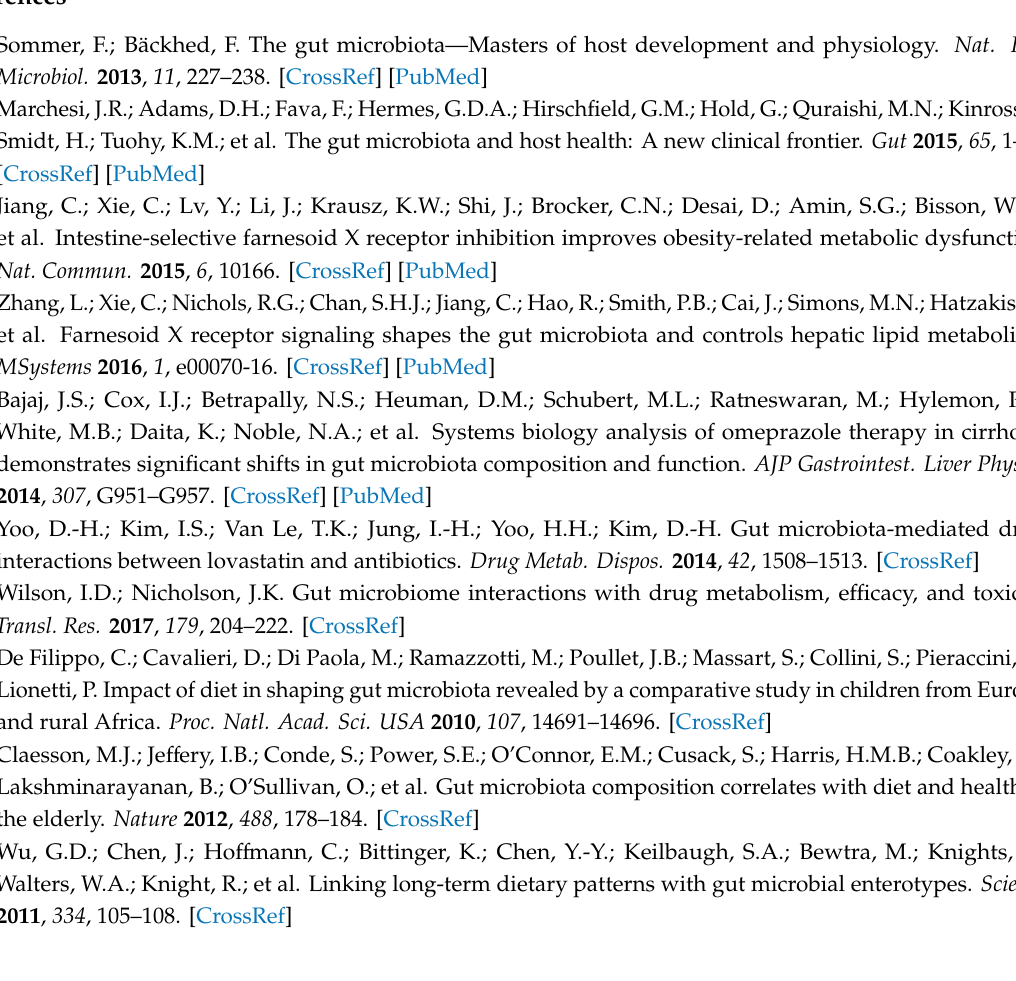
Table S1: chemical composition of a chow diet, Text S1: supplementary